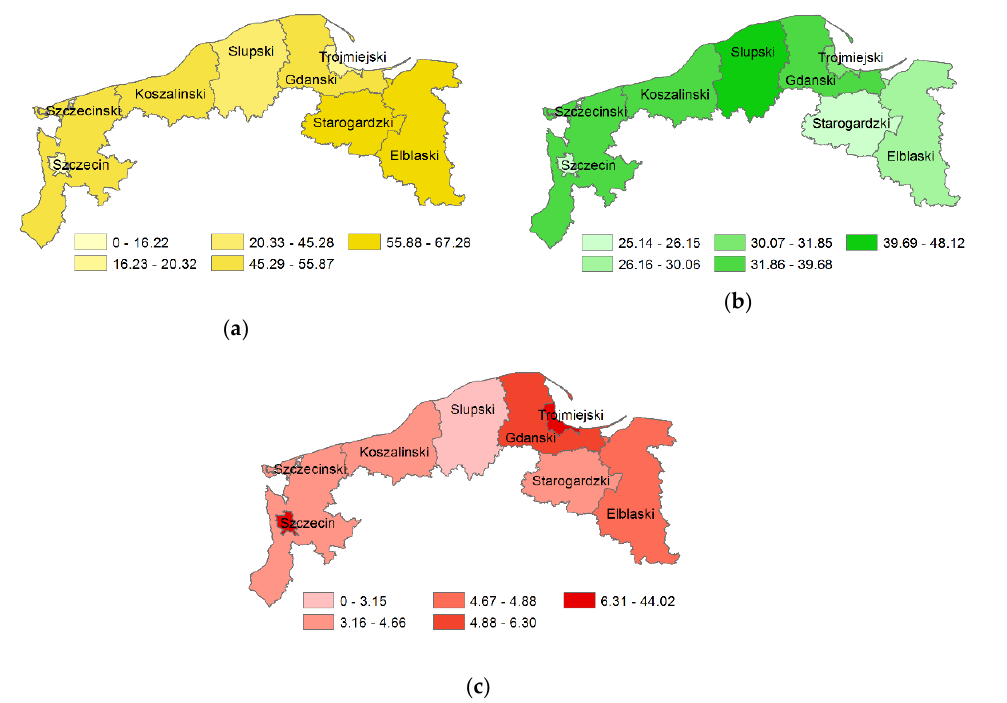
Figure 3. Polish coastal zone land cover structure in percent: ( a ) agricultural areas; ( b ) forest cover; ( c ) artificial surfaces.